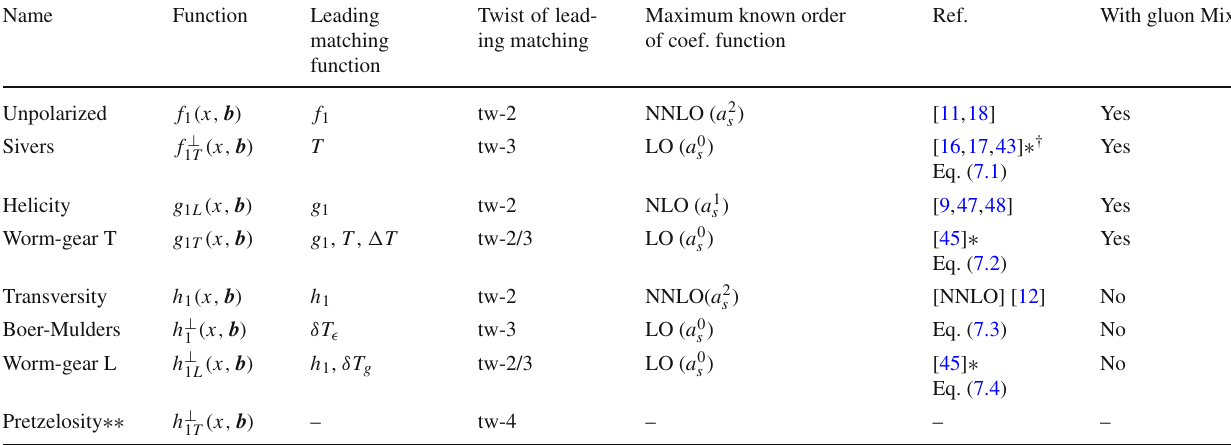
Table 1 The summary of the quark TMD distributions and their leading matching at